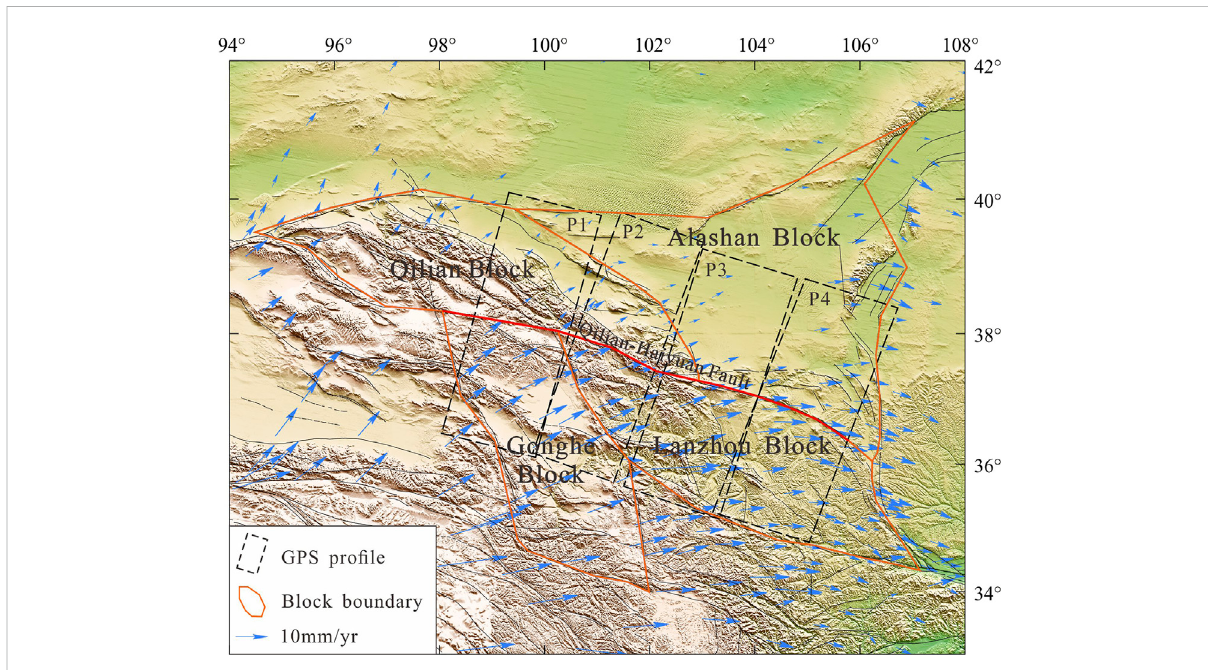
FIGURE 2 GPS horizontalvelocity fi elds andblockboundaries.The red lineindicates theQilian – Haiyuanfault zone. Theorangelines indicate active block boundaries. Blue arrows represent the GPS horizontal velocities with respect to stable Eurasia plate. Black dotted rectangles show the locations of GPS horizontal velocity pro fi les in Figure